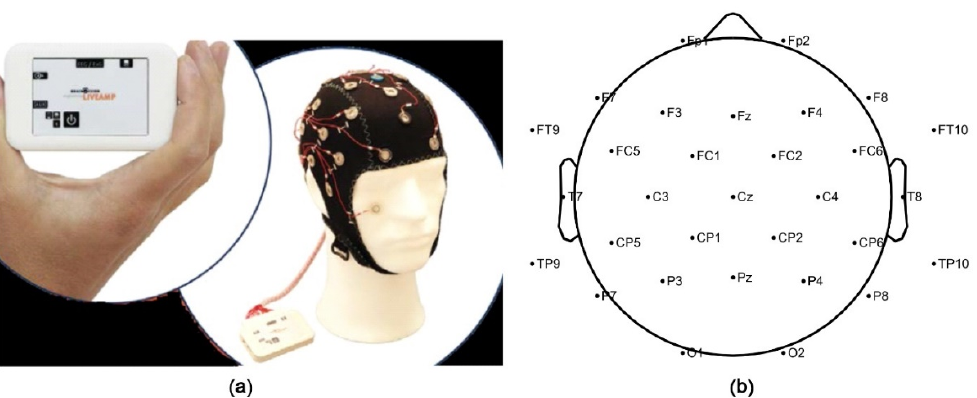
Figure 2. Brain Products (LiveAmp) in the experiment. ( a ) Brain Products (LiveAmp) with 32 channels; ( b ) The electrode position of international 10–20 system with 32 channels.